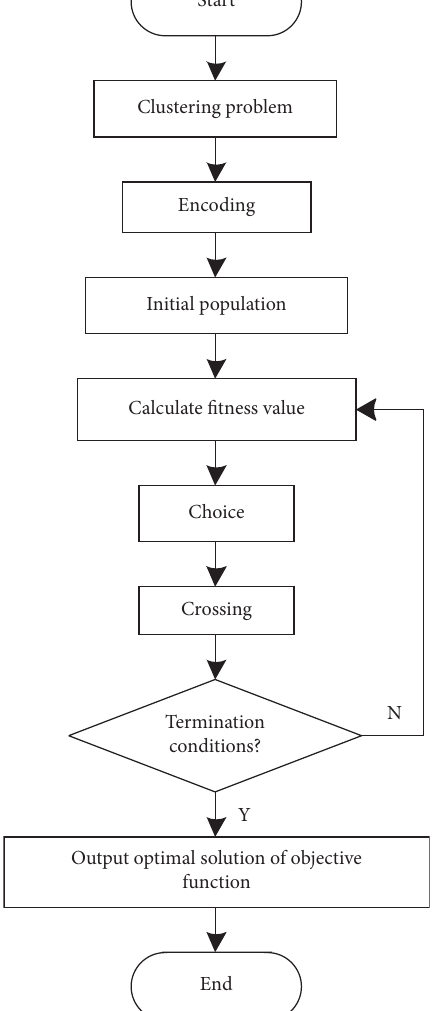
Figure 1: Collaborative product design text knowledge clustering